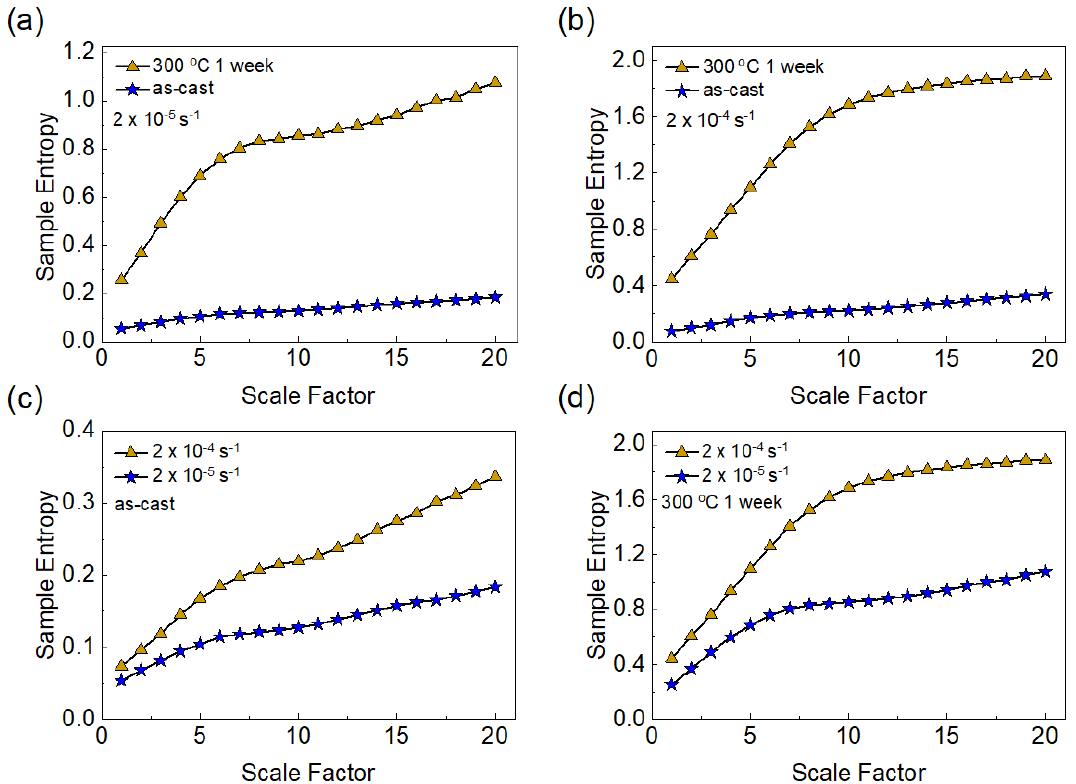
Figure 4. A comparison of the sample entropy vs. the scale factor for the ( a ) as-cast and annealed (300 ◦ C, 1 week) Zr 52.5 Cu 17.9 Ni 14.6 Al 10 Ti 5 BMG specimen that was compressed at a strain rate of 2 × 10 − 5 s − 1 , ( b ) as-cast and annealed (300 ◦ C, 1 week) Zr 52.5 Cu 17.9 Ni 14.6 Al 10 Ti 5 BMG specimen that was compressed at a strain rate of 2 × 10 − 4 s − 1 , ( c ) as-cast samples compressed at strain rates of 2 × 10 − 5 s − 1 and 2 × 10 − 4 s − 1 , and ( d ) the annealed sample (300 ◦ C, 1 week) compressed at strain rates of 2 × 10 − 5 s − 1 and 2 × 10 − 4 s − 1 .